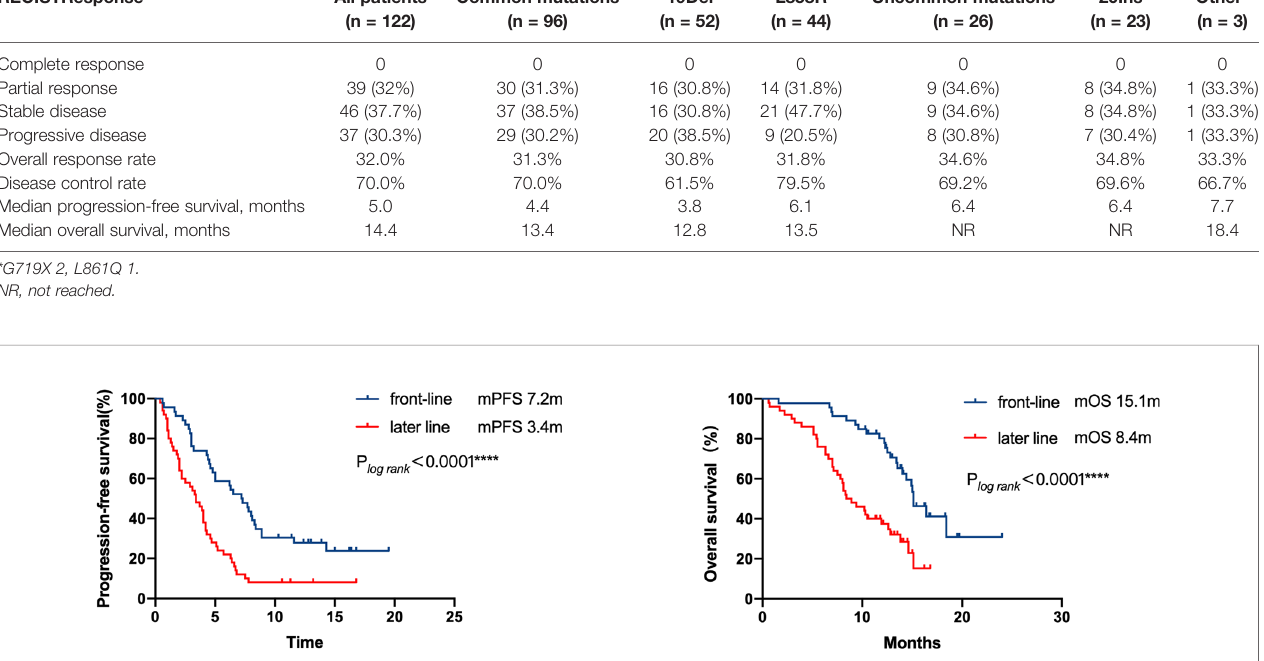
TABLE 2 | The treatment responses of different EGFR mutation types. RECISTResponse All patients